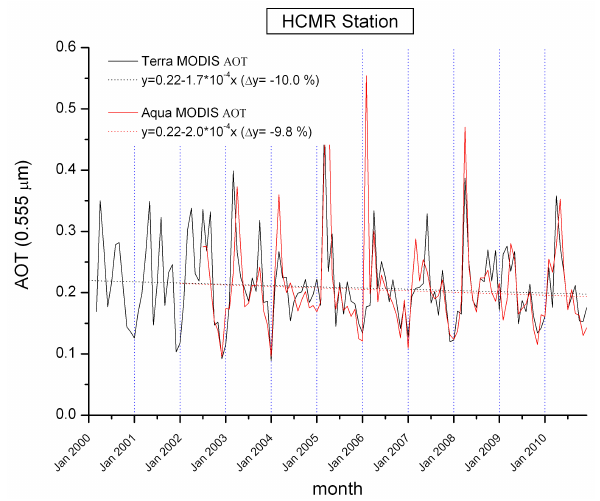
Fig. 11. Time series of the monthly mean AOT at 0.555µm, based on MODIS Level 2 Terra and Aqua data, for the period 2000–2010, at the HCMR station, Crete. The applied linear fits to the time series are also shown (dotted lines).